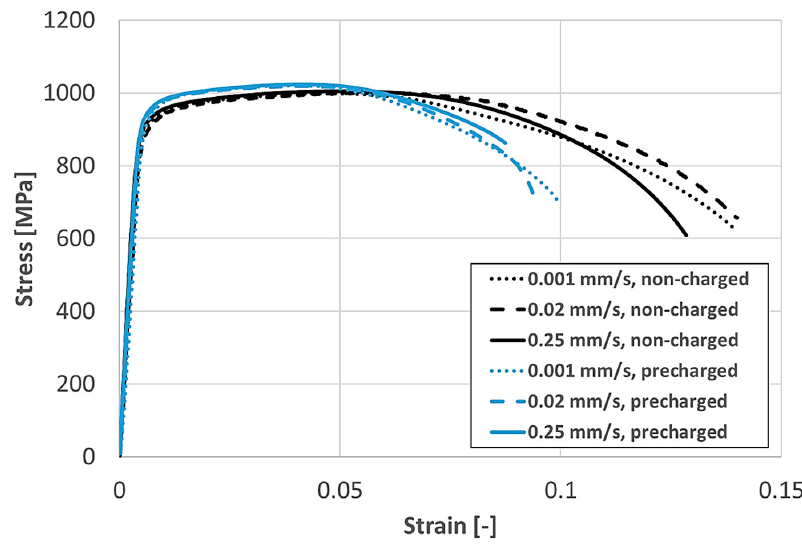
Figure 6. Stress–strain curves acquired via tensile tests with different strain rates on hydrogen ‐ precharged and non ‐ charged specimens. precharged and non-charged specimens. Table 3. Mechanical properties determined during tensile tests with different crosshead speeds in air and after hydrogen